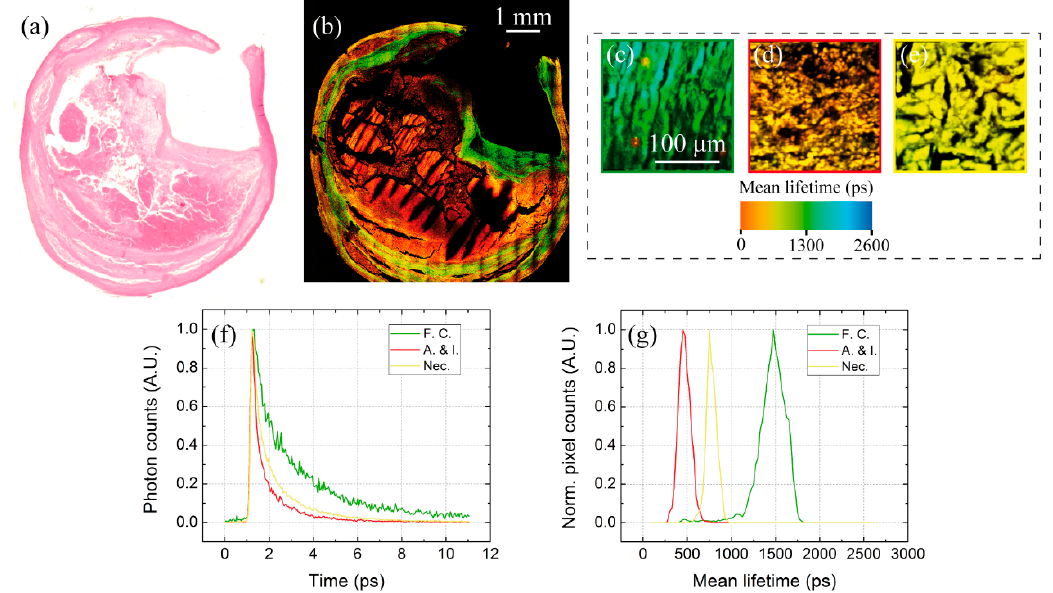
Figure 9. ( a – b ) H&E image of a human carotid cross-section and MPM false color mapping (SHG green, TPEF red) of the adjacent unlabeled slice. ( c – e ) False color FLIM images of fibrous cap (F.C.), angiogenesis and inflammation (A.& I.) and necrotic (Nec.) tissues. ( f ) Fluorescence decays recorded from the three tissues, with the distributions ( g ) of their corresponding mean lifetime values.